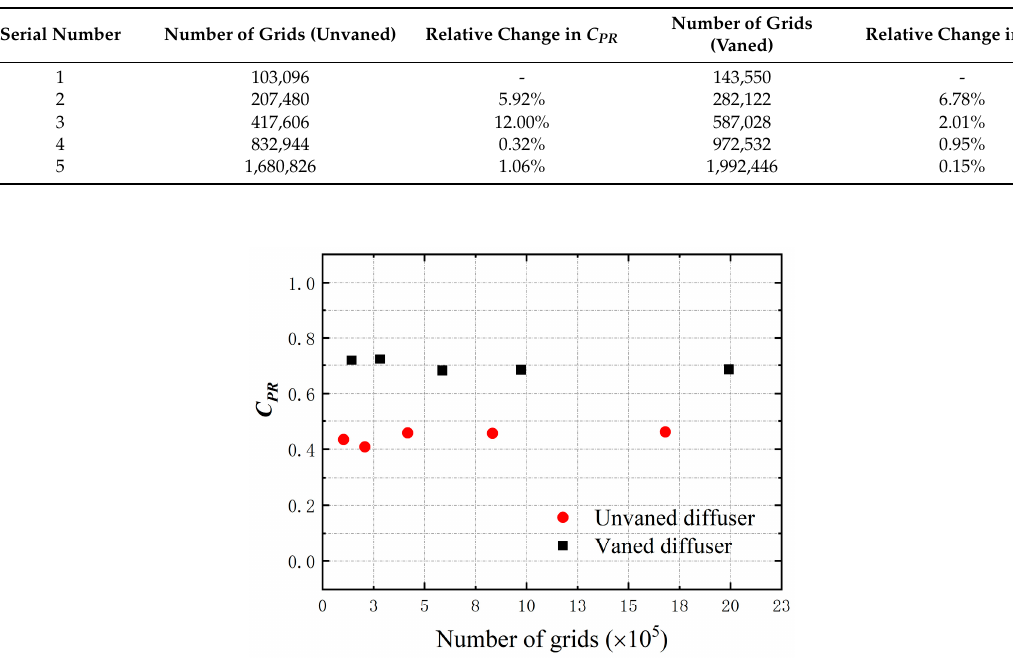
Figure 4. Distributions of y + on the diffuser walls.